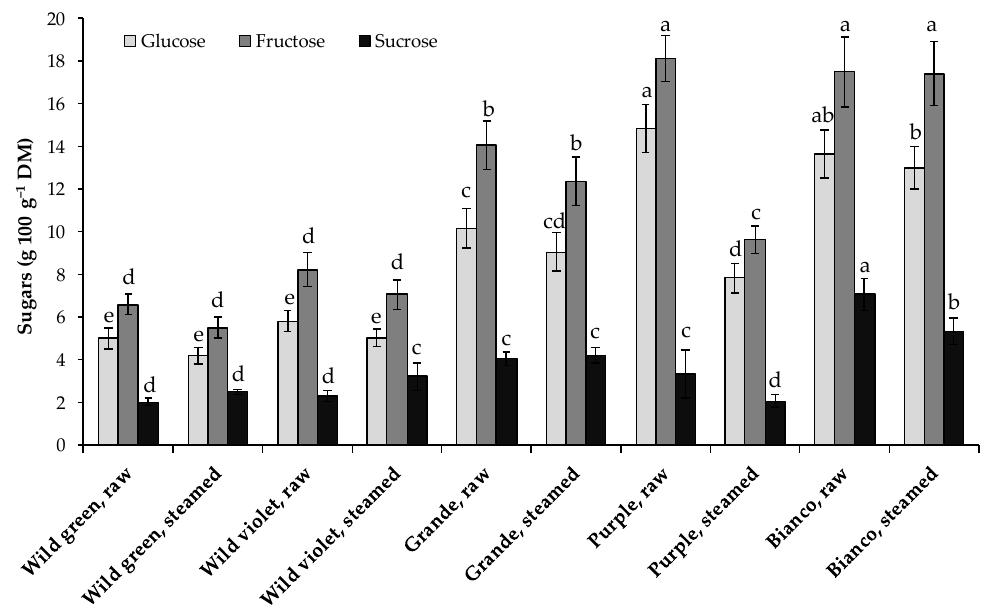
Figure 6. Content of glucose ( p ≤ 0.001), fructose ( p ≤ 0.001), and sucrose ( p ≤ 0.01) in raw and steamed asparagus. For columns of the same color the same letters indicate that mean values are not significantly different ( p = 0.05). Vertical bars indicate the standard deviation. Grande = ‘Grande’; Purple = ‘Purple Passion’; Bianco = ‘Bianco di Bassano del Grappa’.